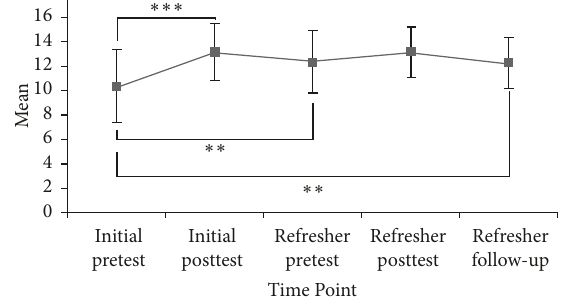
Table 1: Demographic characteristics of healthcare providers.